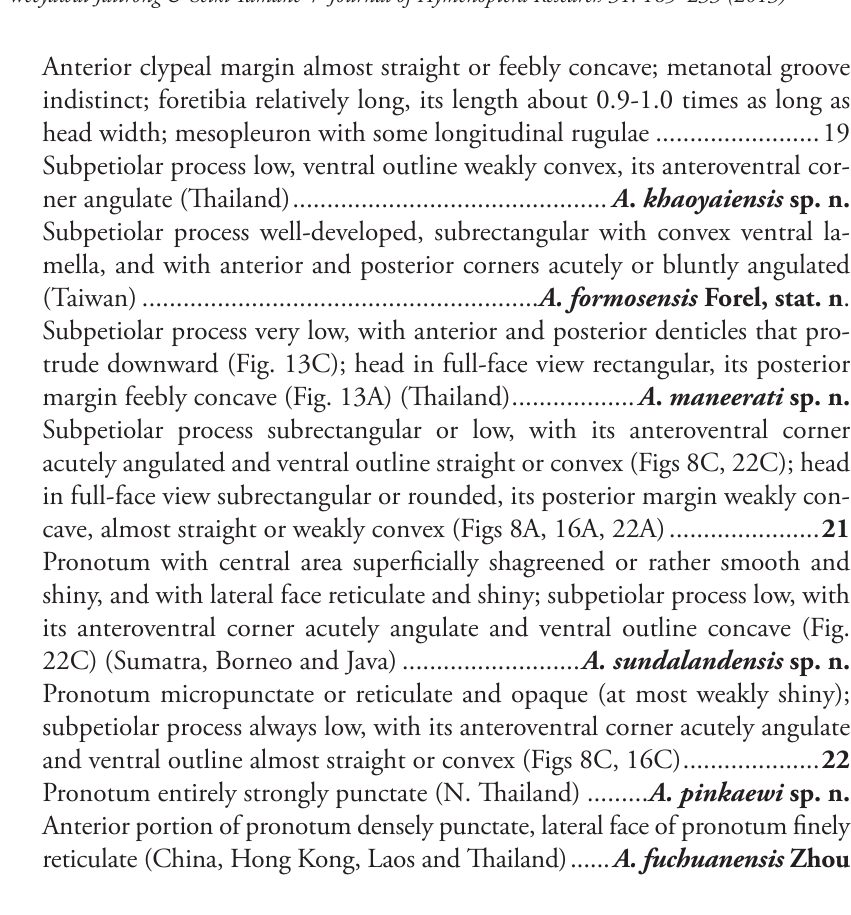
Type material examined. Holotype. MALAYSIA: Worker from E. Malaysia, Borneo, Sabah, Tawau Hills N.P., 7.VII.1996, leg. Sk. Yamane, SB96-SKY-01 (UMS). Para- types . Eight workers, same data as holotype (SKYC, THNHM). Non-type material examined. MALAYSIA: E. Malaysia, Borneo, Sabah, Danum Valley, 3.XI.1996, K. Eguchi leg., Eg96-BOR-153 (SKYC, THNHM). Worker measurements (holotype and paratypes, n = 9). TL 2.70-2.85 mm; HL 0.58-0.60 mm; HW 0.54-0.55 mm; SL 0.45-0.48 mm; ML 0.90-0.95 mm; PL 0.25- 0.28 mm; CI 92-93; SI 84-88. Worker description (holotype and paratypes). Head in full-face view clearly long- er than broad, anterior portion slightly broader than posterior portion, sides convex, posterior margin almost straight; occipital margin bearing a carina. Antennal